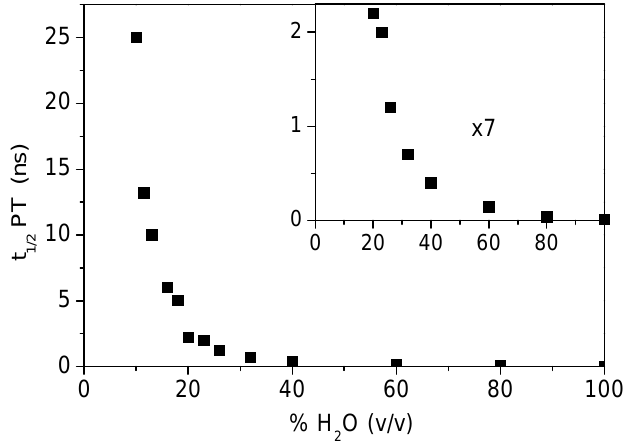
Figure 3. Variation of the characteristic time (ns) of protonation by water of the 44BPY - anion radical as a function of the water content (% in volume) in acetonitrile-water solvent mixtures (DABCO concentration of 0.5 M).